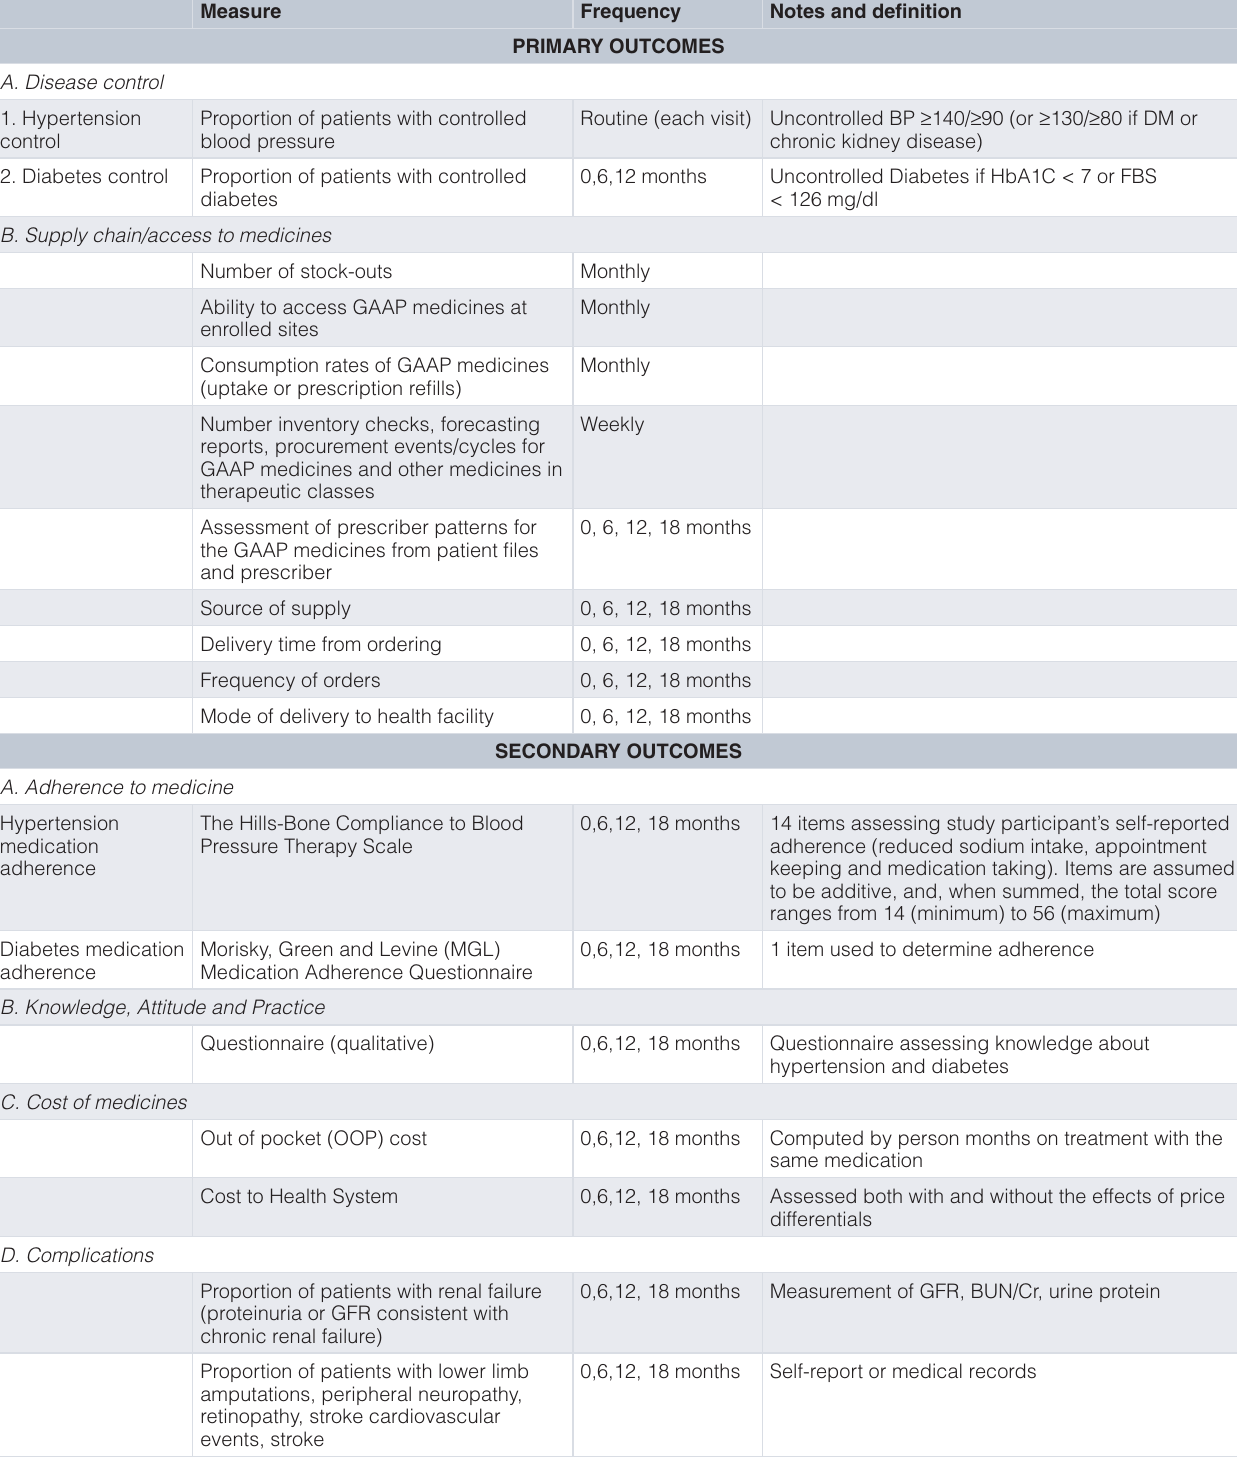
Table 3. Study outcome